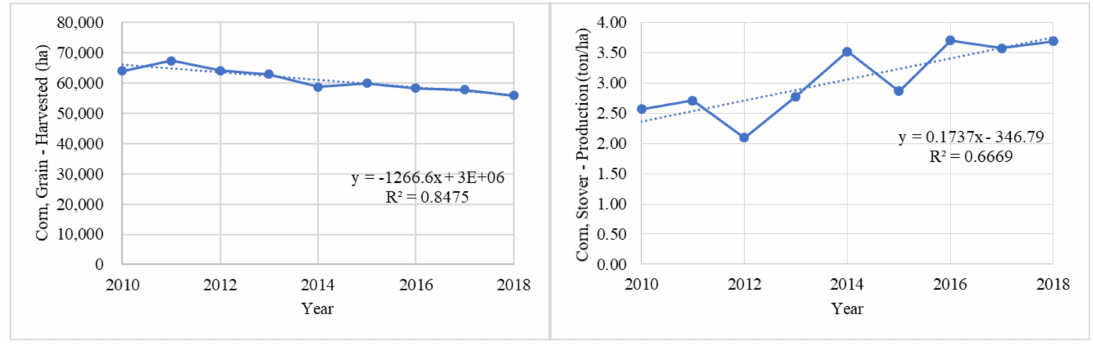
Figure 4. Graphical view of corn and corn stover yield data for Tazewell County in Illinois,